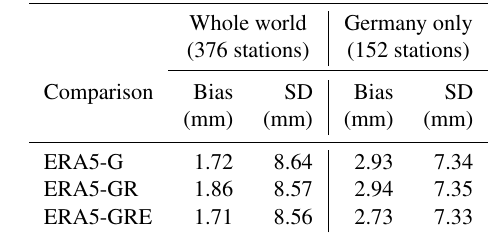
Table 4. Statistics between the ZTD from ERA5 and GNSS solu- tions averaged from the year 2020 and all